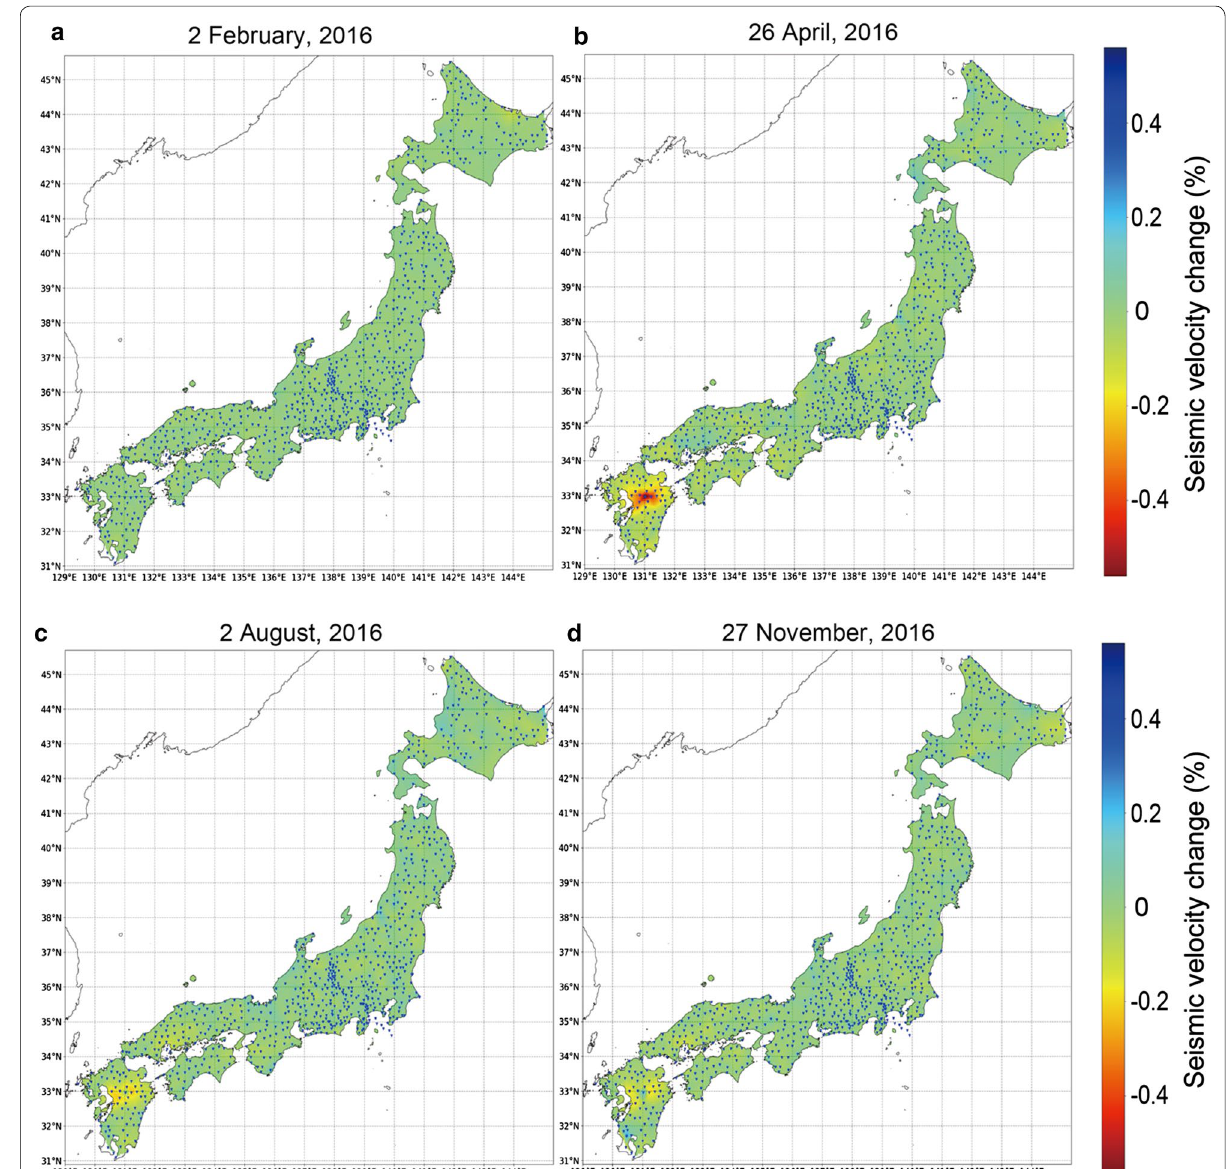
Fig. 5 Spatio-temporal variation of seismic velocity of whole Japanese Islands. This velocity variation was derived by applying SRM to ambient-noise data recorded by 767 Hi-net stations (blue symbols). Each panel shows the latest date within the window of current trace: a 2 February 2016, b 26 April 2016, c 2 August 2016, and d 27 November 2016. Warm colors indicate regions where seismic velocity was decreased. The Kumamoto earthquakes (Mw7) occurred on 16 April, and the Mt Aso eruptions occurred on 7 and 8